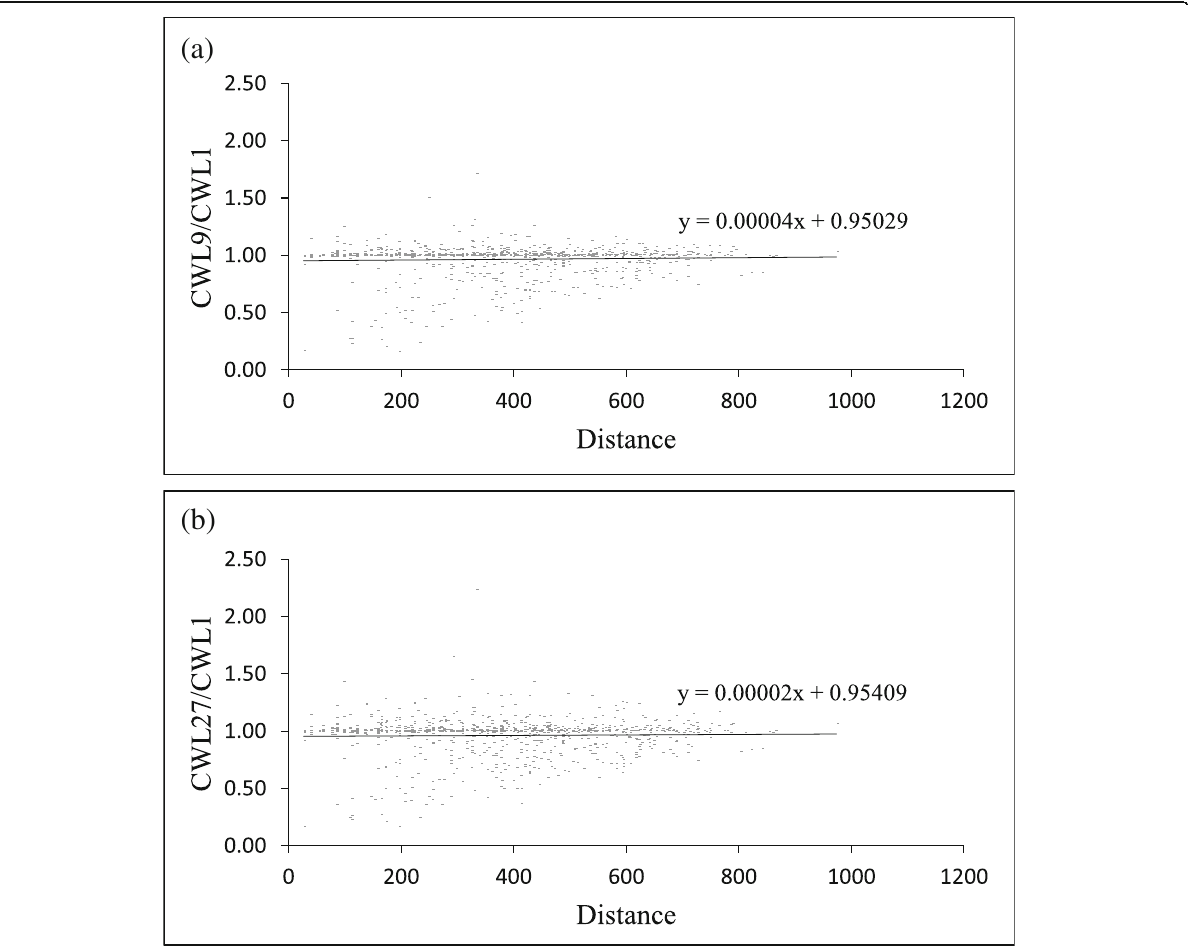
Fig. 6 Plots of 1000 sample values of a CWL9/CWL1 and b CWL27/CWL1 against straight-line source-to-sink distance in the case of two